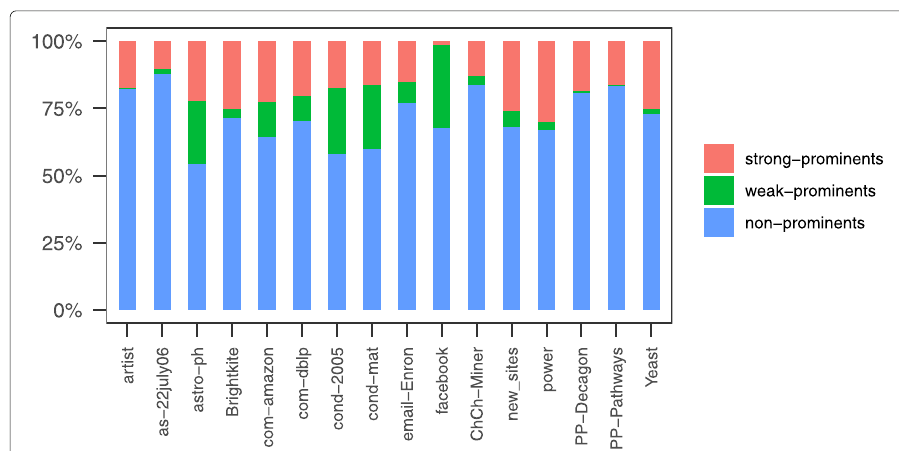
Fig. 3 Prominency types in real-world networks. The bar chart shows, in particular, the difference in the proportion of weakly-prominent nodes. This proportion is especially high in the collaboration networks (astro-ph, cond-mat, cond-mat-2005), and low in the biological (ChCh-Miner, PP-Decagon, PP-Pathways, Yeast) and technological (as-22july06, power)